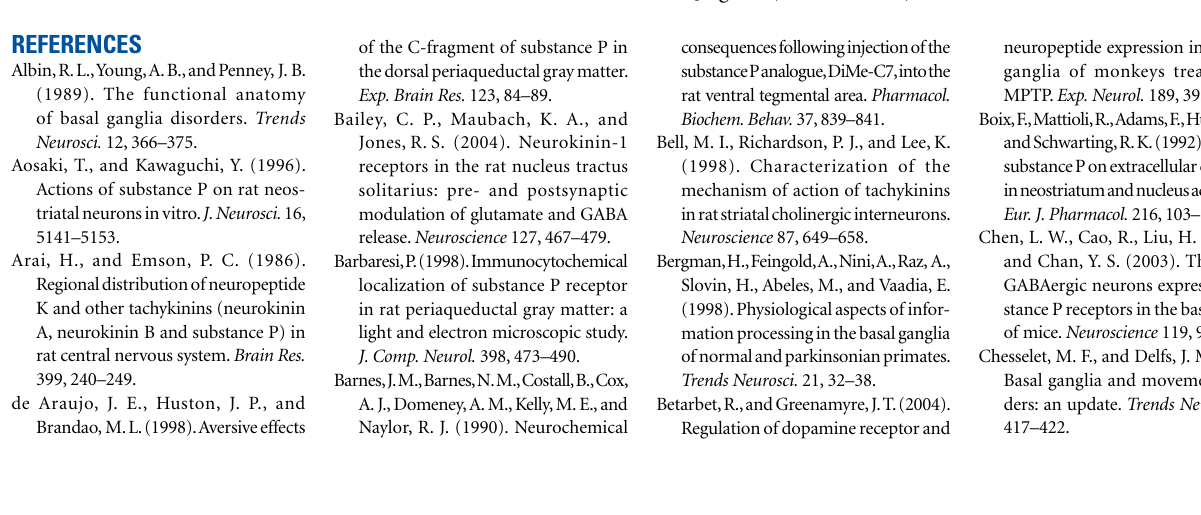
FIGURE 6 | Expression of substance P receptors in globus pallidus of rat aged 14 days. (A) Substance P receptors were moderately expressed by rat globus pallidus neurons. (B) High-magnifi cation photomicrograph shows that substance P receptor immunoreactive neurons were either multipolar or fusiform in shape, and that immunoreactivity was observed predominately along the membrane of both the soma (arrows) and dendrites (arrowheads) of rat globus pallidus neurons. Scale bars: 100 µm (A) ; 25 µm (B)